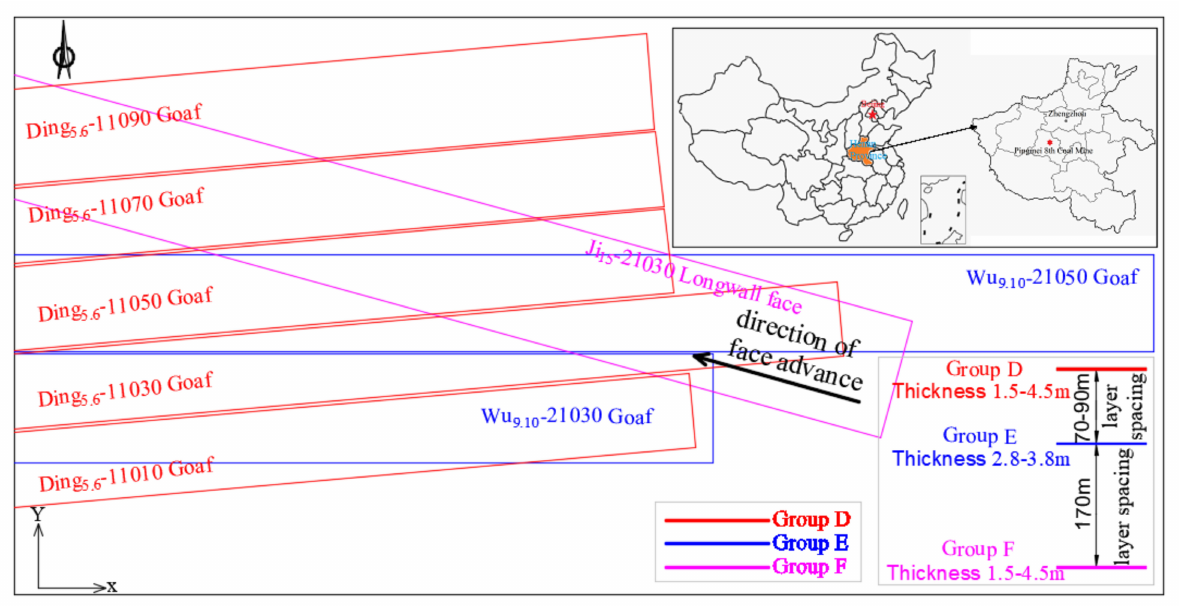
Figure 1. Spatial distribution of the working